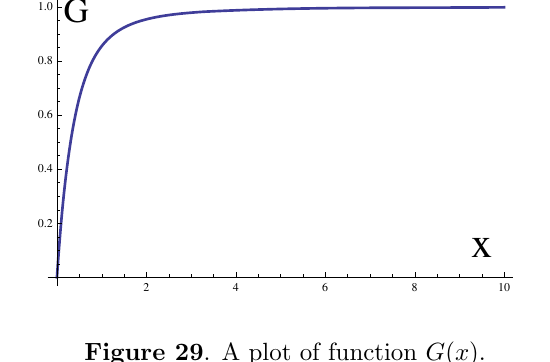
Figure 29 . A plot of function G ( x ).